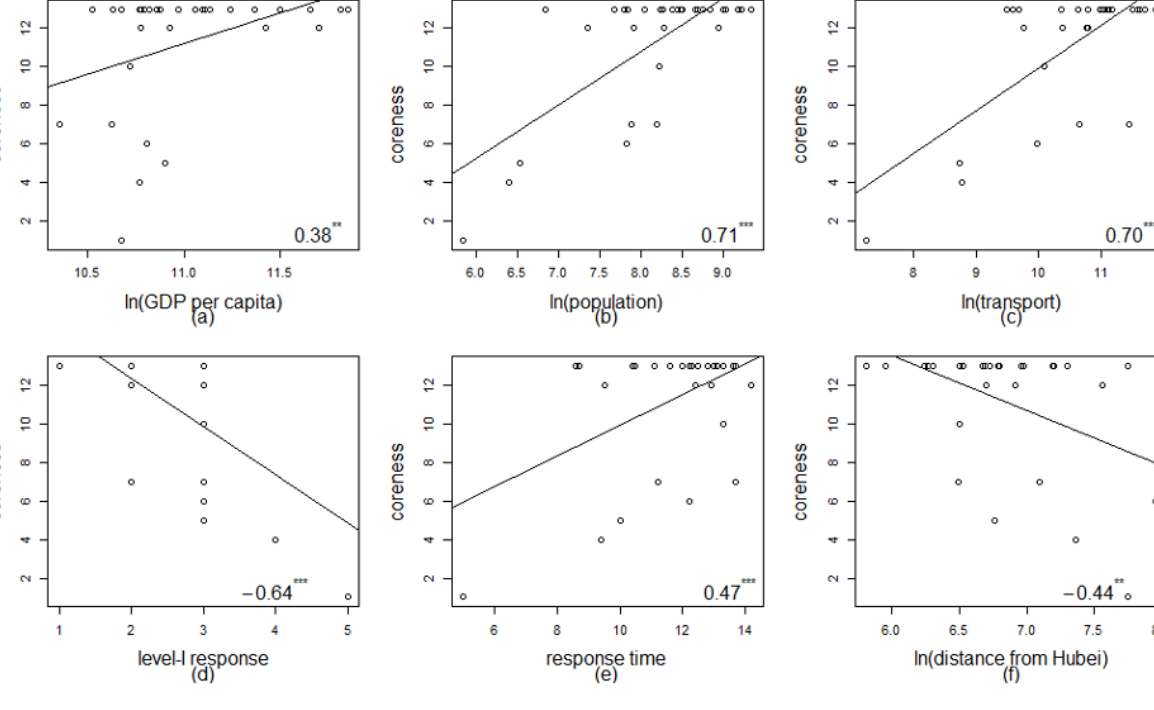
Figure 8. Daily evolution of the maximum coreness ( k max ) in the COVID-19 epidemic